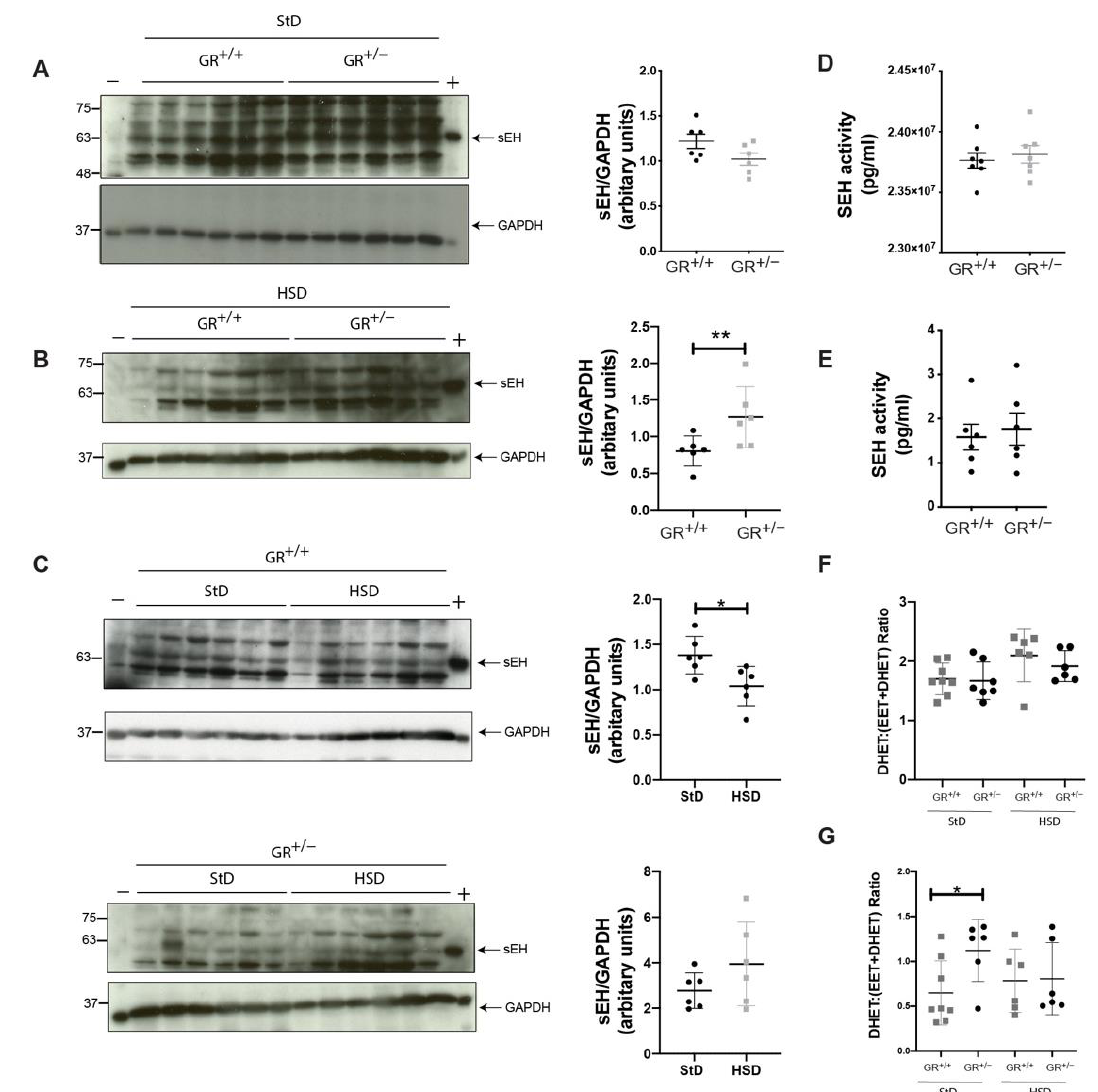
Figure 4. sEH protein levels remain elevated in GR +/ − rats under high salt diet. ( A ) Representative Western blot analysis and quantification of sEH protein expression under standard diet and ( B ) under high salt diet; ( C ) representative Western blot analysis and quantification of sEH protein expression in the adrenal glands of GR +/+ rats (n = 6) under standard and high salt diet (upper panel) and representative Western blot analysis and its quantification of sEH protein expression in the adrenal glands of GR +/ − rats (n = 6) under standard and high salt diet; ( D ) enzymatic activity of sEH in the adrenal glands of GR +/+ (n = 6) and GR +/ − rats (n = 6) under standard diet; ( E ) enzymatic activity of sEH in the adrenal glands of GR +/+ (n = 6) and GR +/ − rats (n = 6) under high salt diet; ( F ) sEH activity was estimated indirectly by the molar ratios of individual and total DHET/(EET + DHET) for arachidonic acids and ( G ) for linoleic acids. Values are indicated as mean ± SEM, and data were evaluated by unpaired two-tailed t test and differences assessed at * p < 0.05, ** p < 0.01.